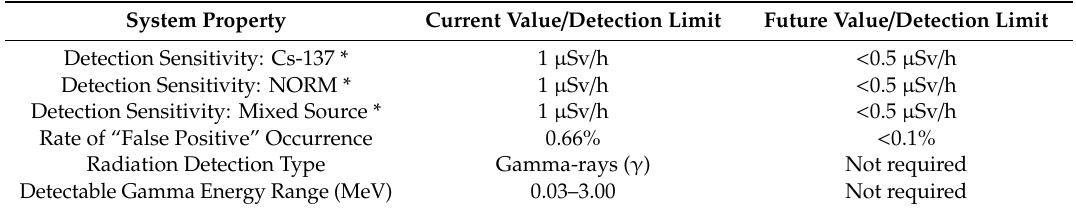
Table 4. Summary of the current properties of the Gatekeeper platform alongside the intended future performance